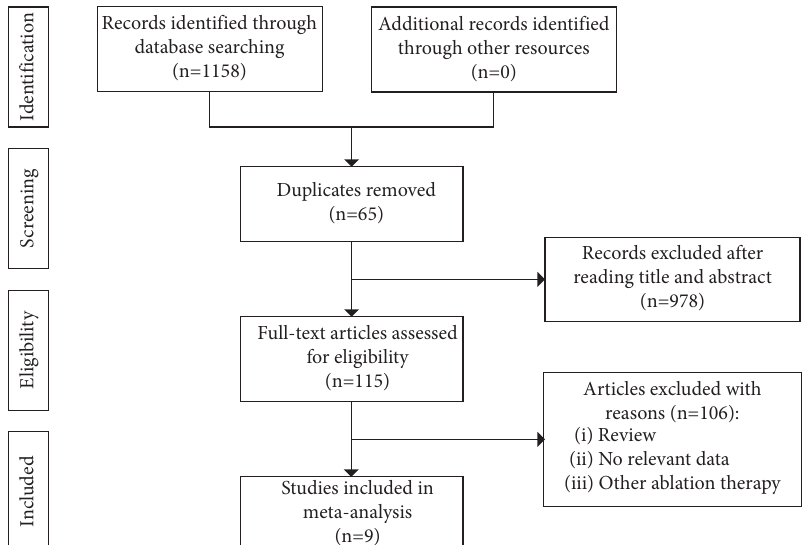
Figure 1: Flowchart showing the study selection